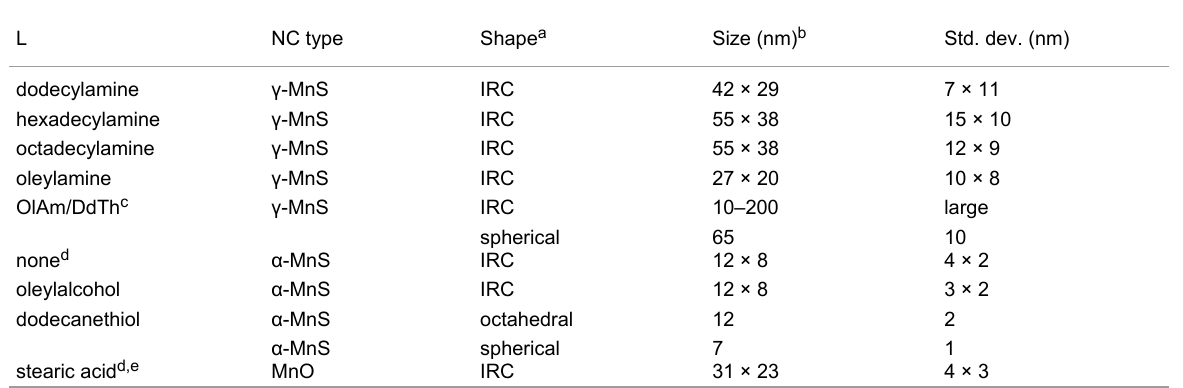
Table 1: Properties of NCs synthesized by the thermal decomposition of MnSt 2 with S/Mn = 2 and L/Mn = 4.